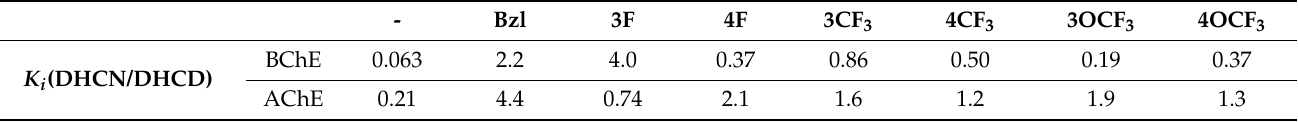
Table 4. Stereoselectivity of BChE and AChE toward pseudo-enantiomers of 10, 11-dihydro